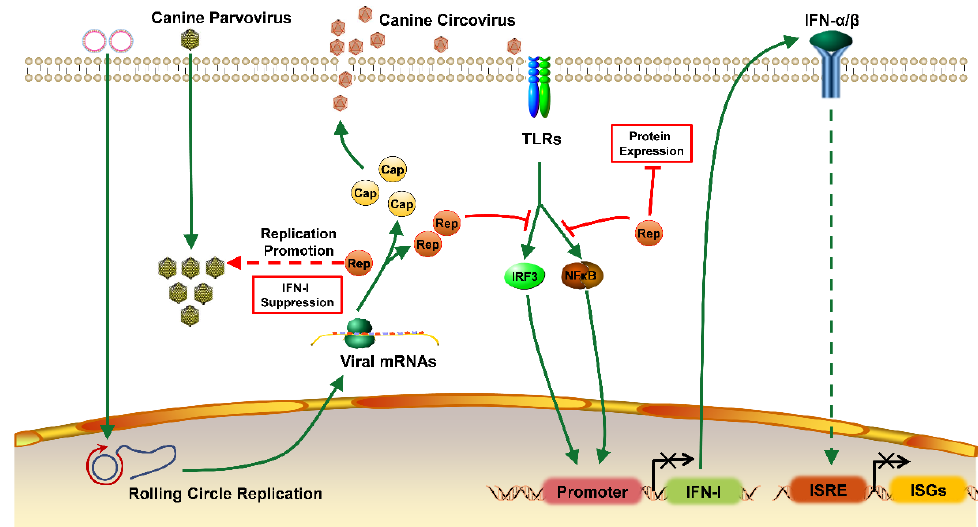
Figure 6. Schematic diagram of the effect of CanineCV on the IFN-I signaling pathway and CPV-2 replication. Infectious clones were transfected into cells, after which viral particles were packaged depending on the characteristics of the rolling loop replication. Then, viral protein expression was initiated, the host cell IFN-I immune pathway was blocked, protein synthesis was reduced, and antiviral defenses were dysregulated. CPV-2 replicates at higher levels in intracellular environments whereas antiviral genes are expressed at low levels.